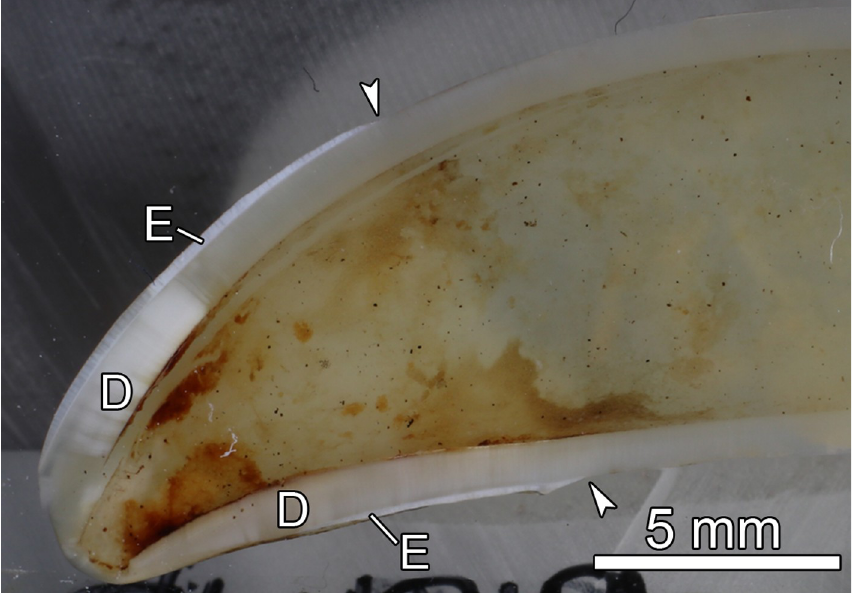
Fig 11. Longitudinally sectioned right maxillary C of specimen ZMUC 69 3 . Exposure of the pulp cavity through an opening at the crown tip. D: dentin; E: enamel; arrowheads: crown-root border. Resin-embedded tooth; labial side directed to upper-left corner of